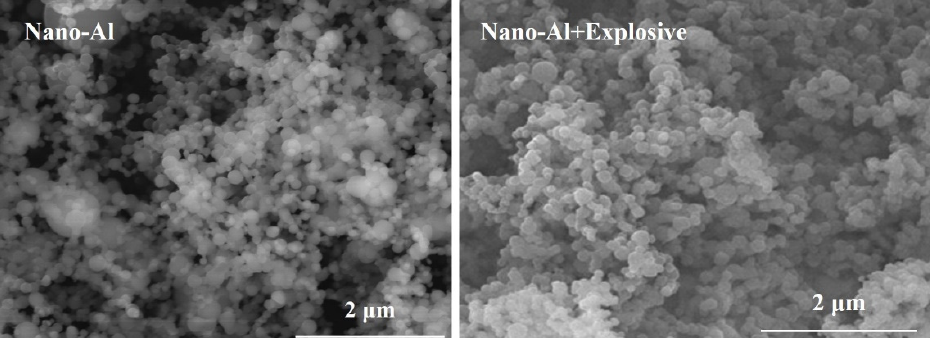
Figure 6. SEM images of nano-Al and explosive containing nano-Al. SEM tests of micron-Al and explosive 2 are provided in Figure 7.